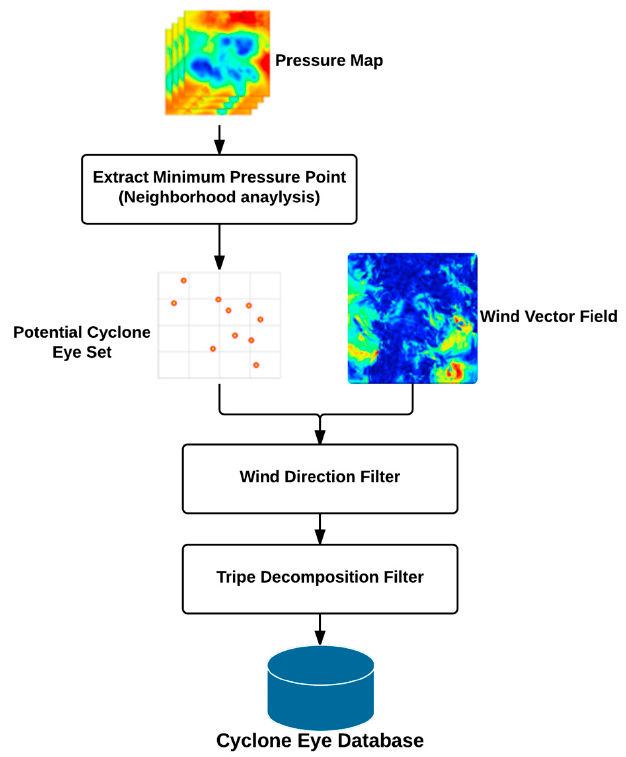
Figure 3. The workflow of our cyclone identification algorithm.